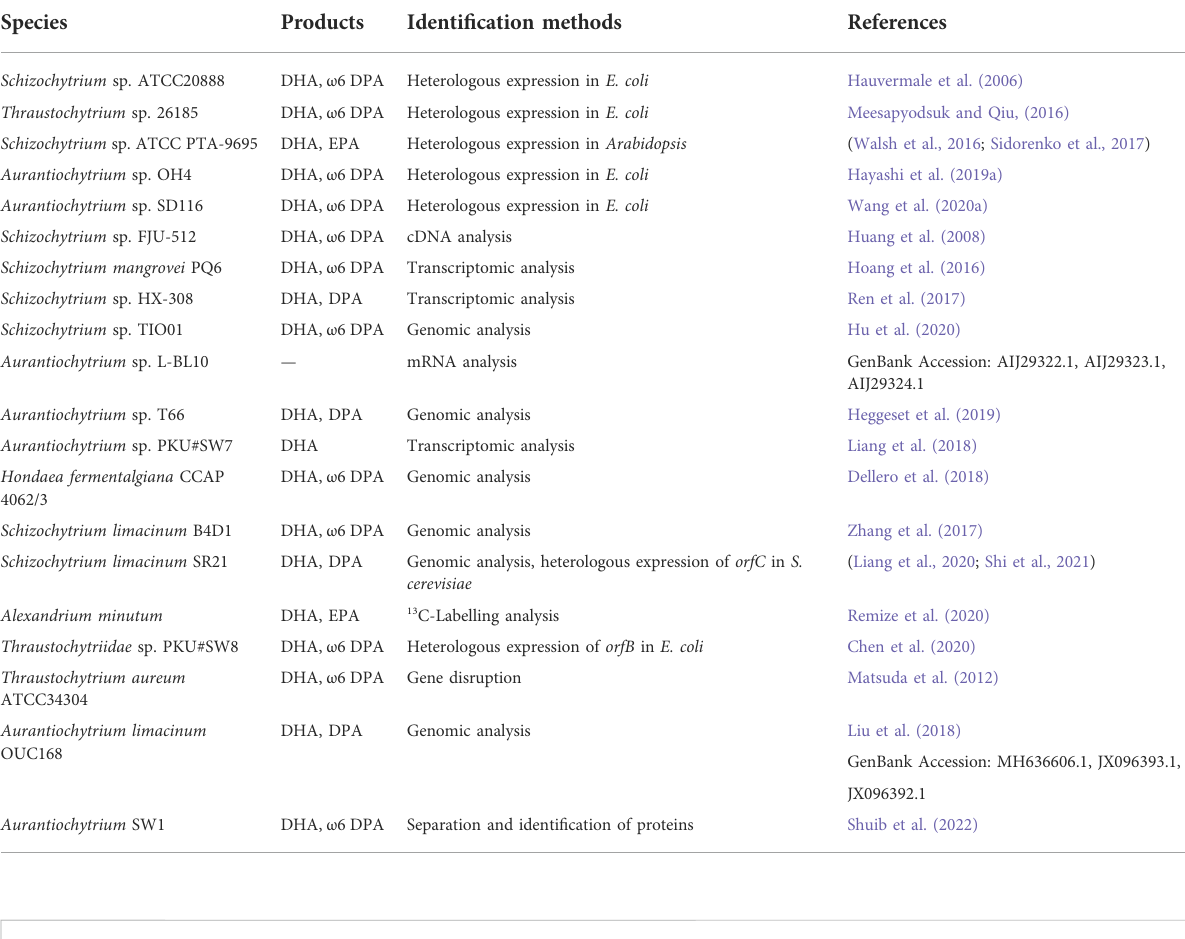
TABLE 1 Identi fi cation of PUFA synthases in eukaryotes.